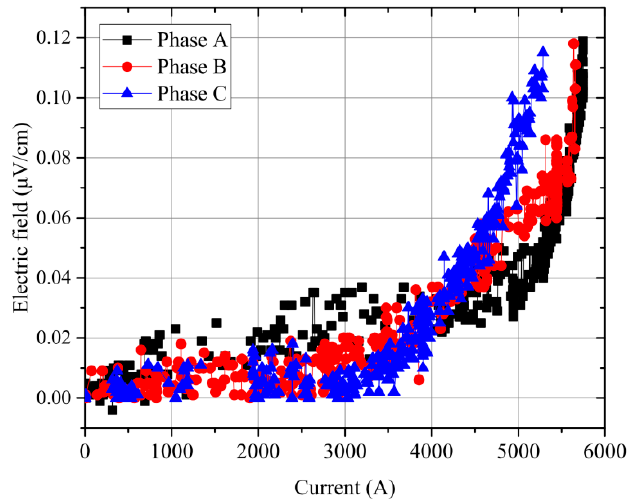
Figure 11. Critical current testing results.